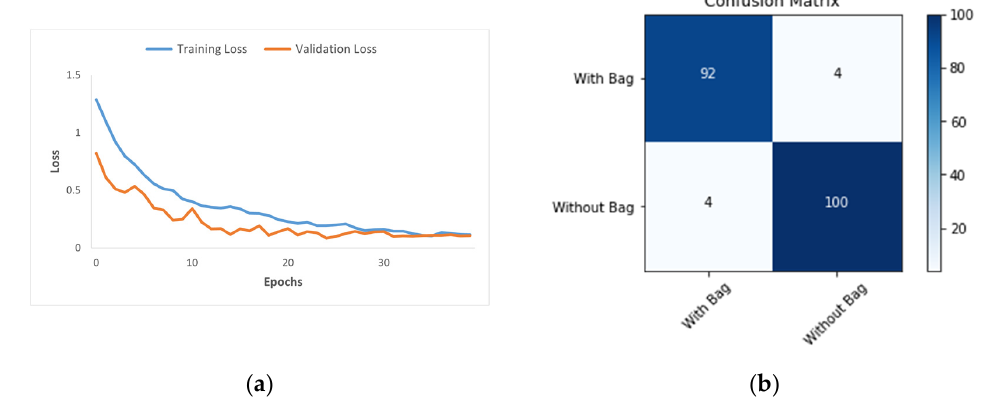
Figure 6. The loss curve and confusion matrix of the first experiment on INRIA and MSMT17 datasets: ( a ) The loss curve, ( b ) the confusion matrix.